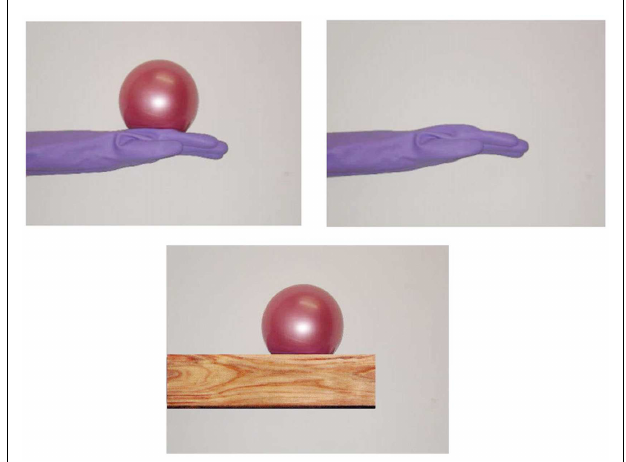
FIGURE 1 |Visual stimuli used in the present